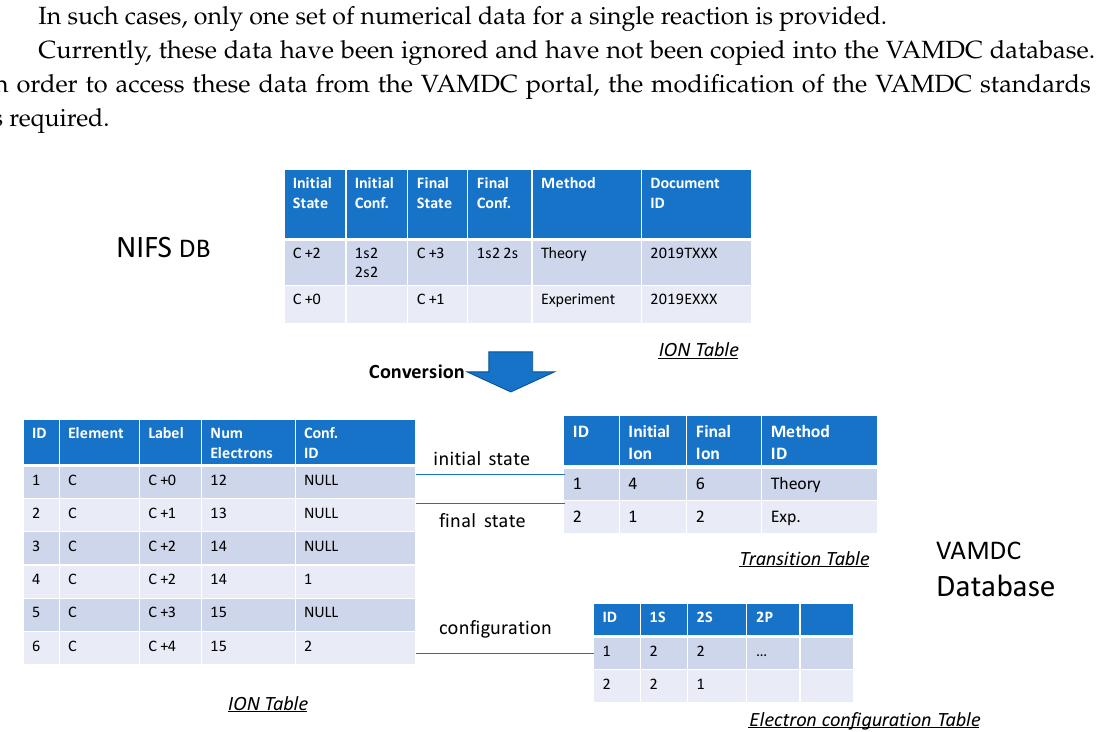
Figure 5. Conversion of the ION table from the NIFS DB to the VAMDC database. The original ION table in the NIFS DB is divided into three tables in the VAMDC database.